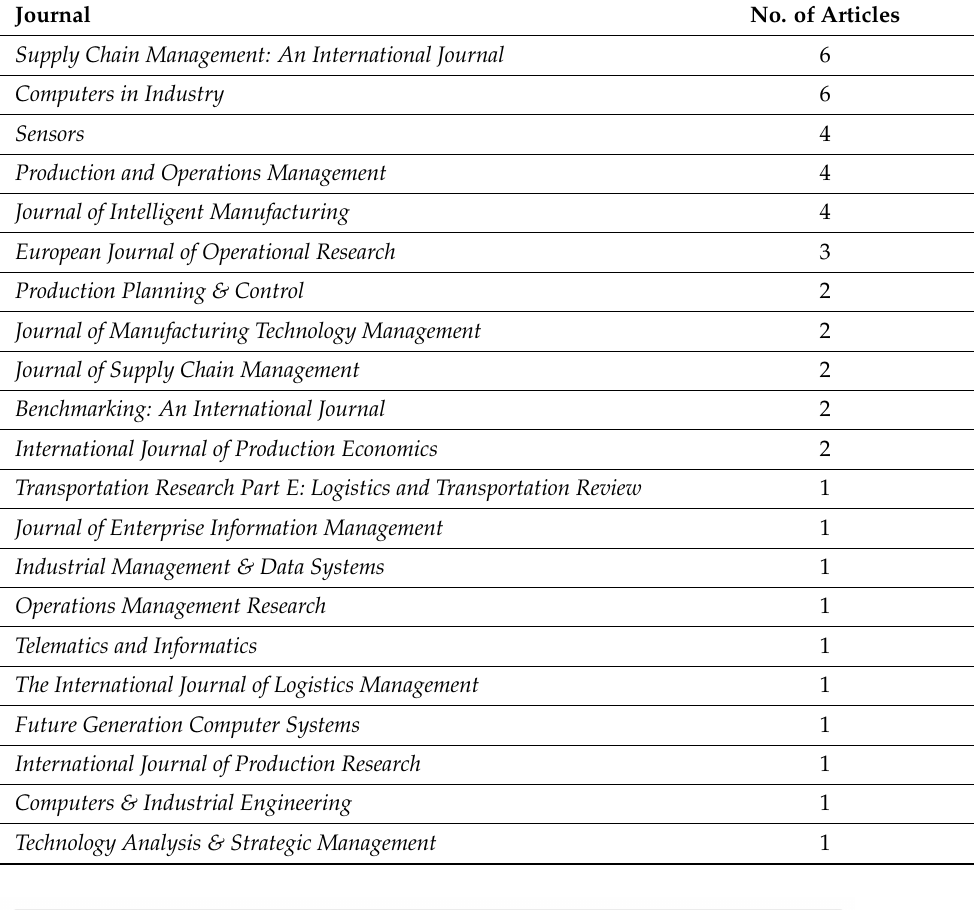
Table 3. Distribution of articles in journals.